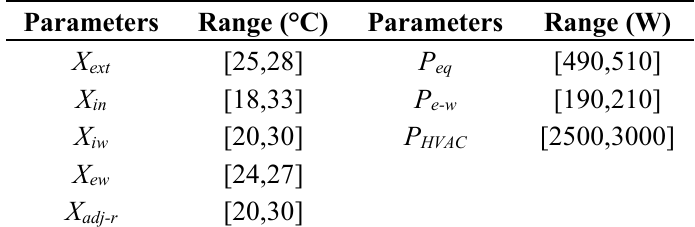
Table A2. Input variables and state variables of air-conditioned space.